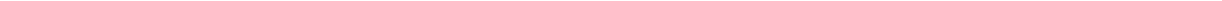
Fig. 4 Mutant GFAP-induced cellular mechanotransduction alterations. a Increased F-actin bundle formation in the astrocytes of 3-month-old Alexander disease model mice ( GFAP R236H / + , arrows) compared to age-matched controls. Phalloidin staining labels F-actin. GFAP marks astrocytes. DAPI labels nuclei. Scale bar is 2 microns. N = 4 (wild type) and 5 ( GFAP R236H / + ). A total of 50 astrocytes per animal were used for quanti fi cation. p = 0.0159, Mann – Whitney test. See Supplementary Data 2 for a 3D reconstruction. b Abundant actin bundles in the glial cells of mutant GFAP transgenic fl ies (GFAP R79H , arrows) labeled by LifeactRFP. Repo marks glial cells. Scale bar is 5 microns. N ≥ 6 animals per genotype. p = 0.0012, Mann – Whitney test. c Western blot shows increased expression of Shot in mutant GFAP transgenic fl ies compared to age-matched controls. N = 6. p = 0.0313, Wilcoxon test. d Genetically reducing shot expression in Alexander disease model fl ies reduced the percentage of glial cells with F-actin. LifeactRFP labels F-actin. Repo marks glial cells. Scale bar is 5 microns. N ≥ 6 per genotype. * p < 0.05, ** p < 0.01, Kruskal – Wallis test. e Immuno fl uoresecence shows increased and clustered expression of integrin (arrows) along F-actin in the glial cells of Alexander disease model fl ies (GFAP R79H , arrows), but not in age-matched controls. Repo marks glial cells. Scale bar is 5 microns. f Western blot shows increased expression of GFP in Alexander disease model fl ies carrying a GFP protein trap reporter for integrin-linked kinase (Ilk) compared to age-matched controls. N = 4. p = 0.0286, Mann – Whitney test. g – j Increased transcript levels of LanA (laminin α subunit), LanB1 (laminin β subunit), LanB2 (laminin γ subunit) and Vinculin ( Vinc ) in mutant GFAP transgenic fl ies compared to age-matched control fl ies. * p < 0.05, ** p < 0.01, Mann – Whitney test ( g , i ) and Wilcoxon test ( h , j ). k , l , Double label immuno fl uorescence and western blot demonstrate increased expression phosphorylated focal adhesion kinase (phospho-FAK) in 3-month-old Alexander disease model mice ( GFAP R236H / + ) compared to age-matched wild-type littermate controls. GFAP marks astrocytes. Scale bars are 10 microns for the top two rows and 2 microns for the insets ( k ). N = 4, p = 0.0221 ( l ). Flies are 20 days old in b – j . Blots are reprobed for actin ( c , f ) or GAPDH ( l ) to illustrate equivalent protein